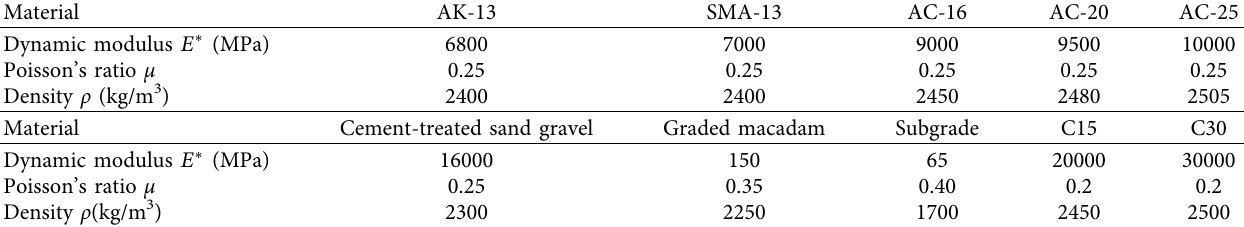
Table 4: Mechanical parameters of pavement materials.